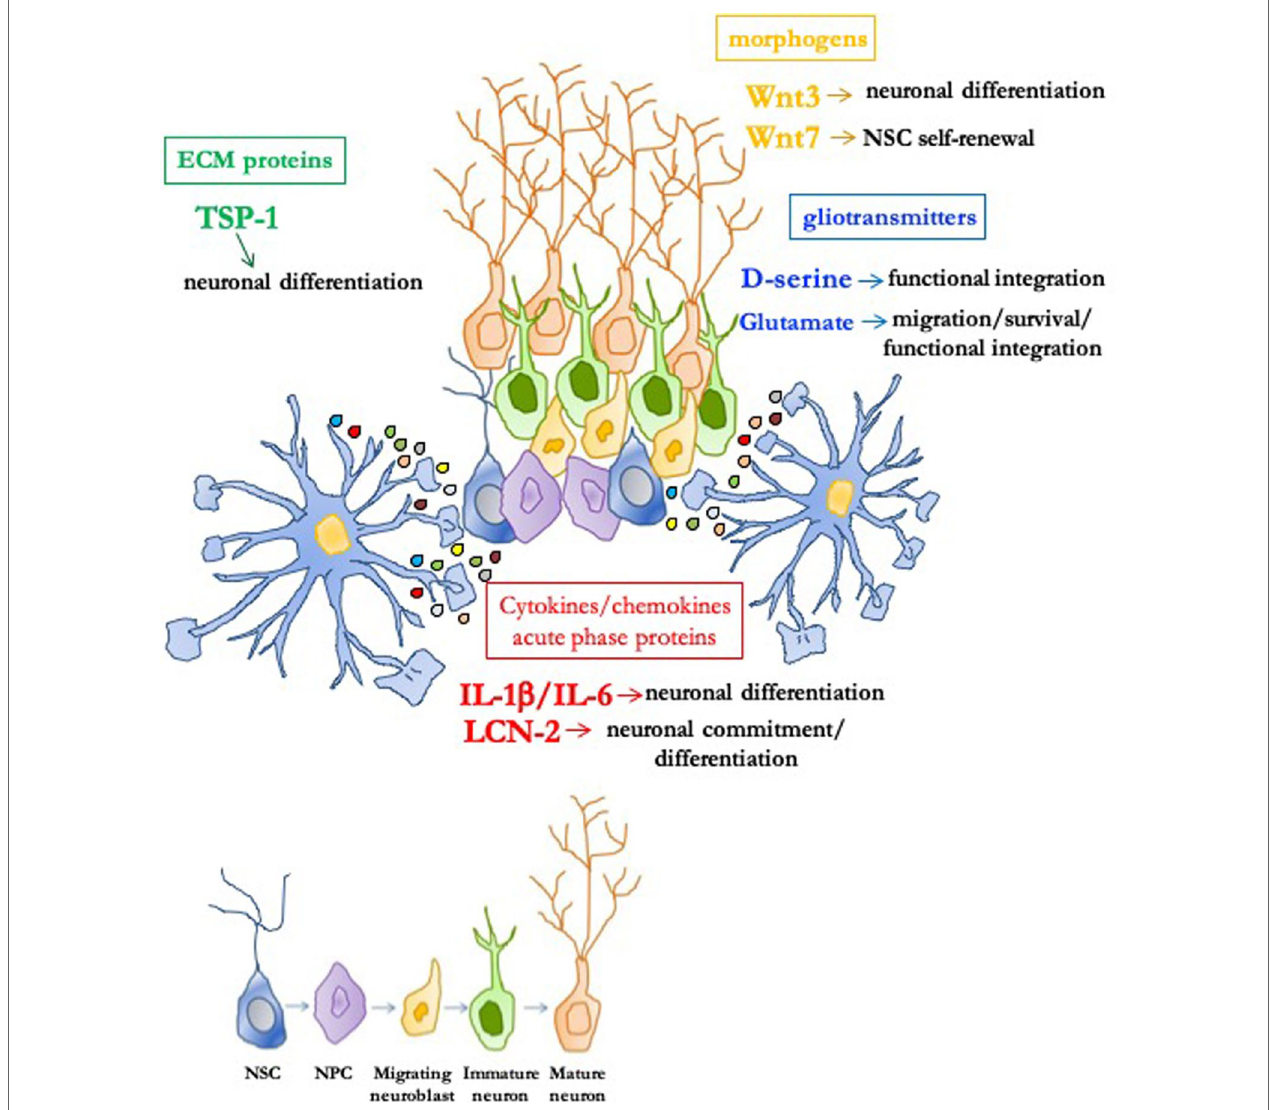
FIGURe 1 | Role of astrocyte-derived molecules in the adult neurogenic niche. In the permissive and instructive microenvironment of the neurogenic niche, astrocytes profoundly modulate adult neurogenesis through soluble signals. Neural stem/progenitor cells (NSC/NPC) self-renewal, neuronal commitment/ differentiation, migration of neuroblasts, as well as survival and functional integration of newly born neurons can be affected by different classes of astrocytic-derived factors such as morphogens (i.e., Wnt3 and Wnt7), gliotransmitters (i.e., D-serine and glutamate), extracellular matrix (ECM) proteins [i.e., thrombospondin 1 (TSP- 1)], and cytokines/chemokines/acute phase proteins [i.e., IL-1β, IL-6, and lipocalin-2